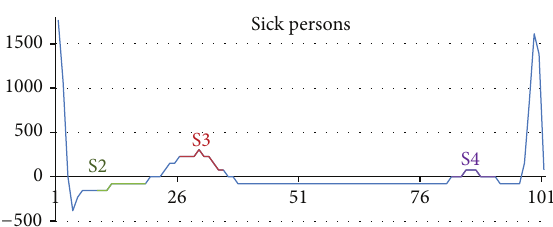
Figure 8: Some recognized patterns that occur in ECG time